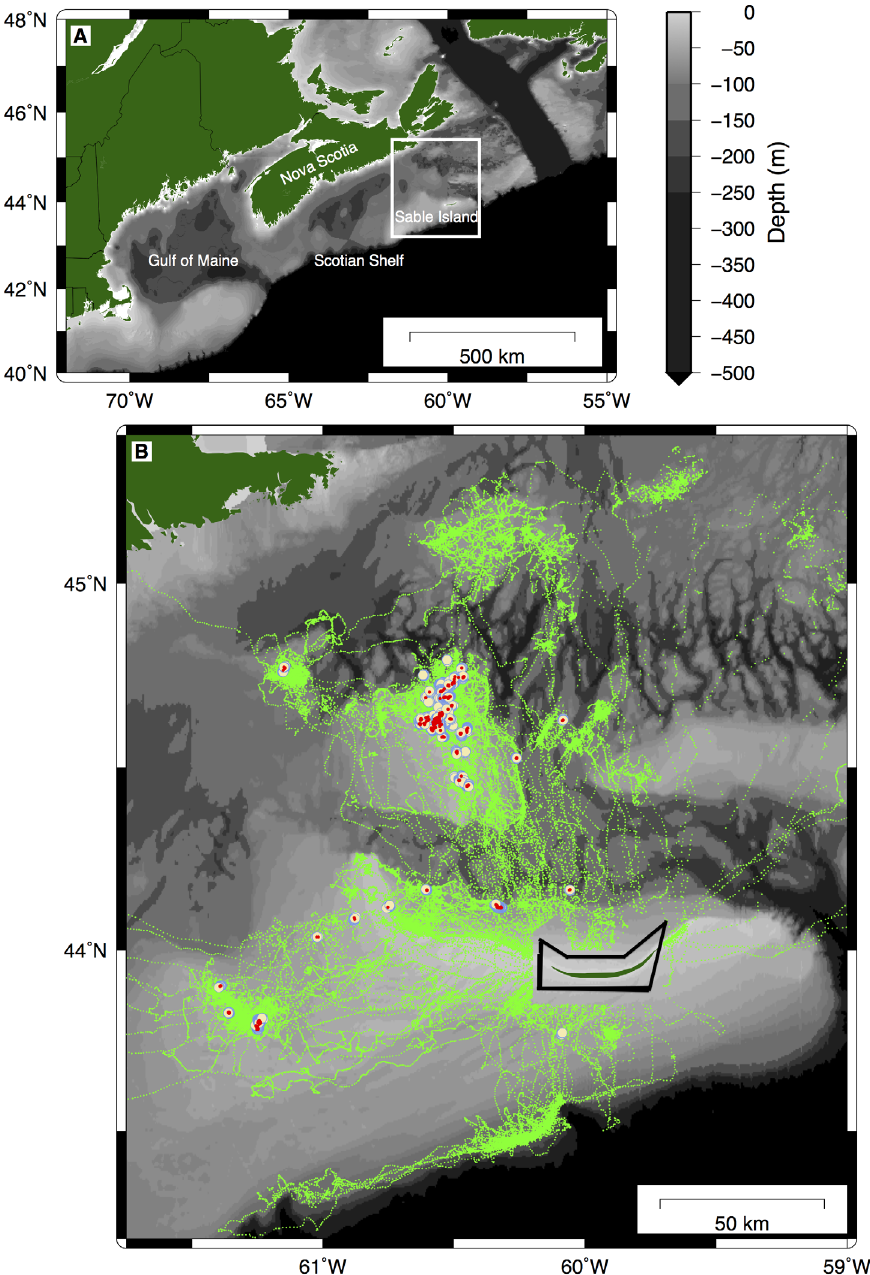
Figure 1. Study area and seal tracks. Nova Scotia and the Scotian Shelf (A) with the study area showing GPS tracks (green) and VMT expected (white) and observed (red) detections (B). The main shallow banks in the region are outlined with their 100 m isobaths (grey).